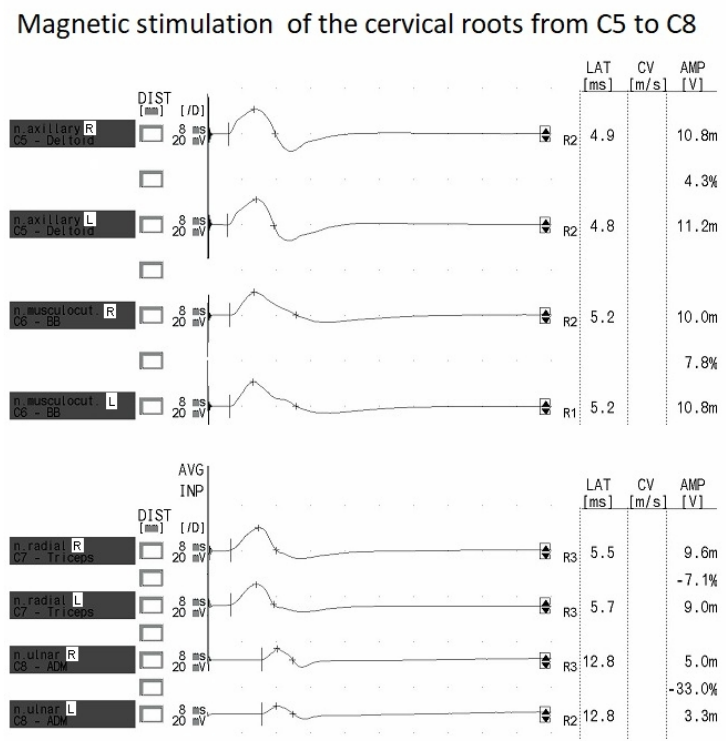
Figure 5. MEP recordings following magnetic stimulation of C5 to C8 cervical spinal roots.